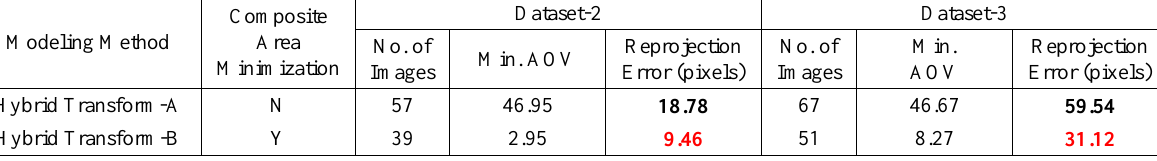
Table 3. Mosaic deformation results for the subsets of Dataset-2 and